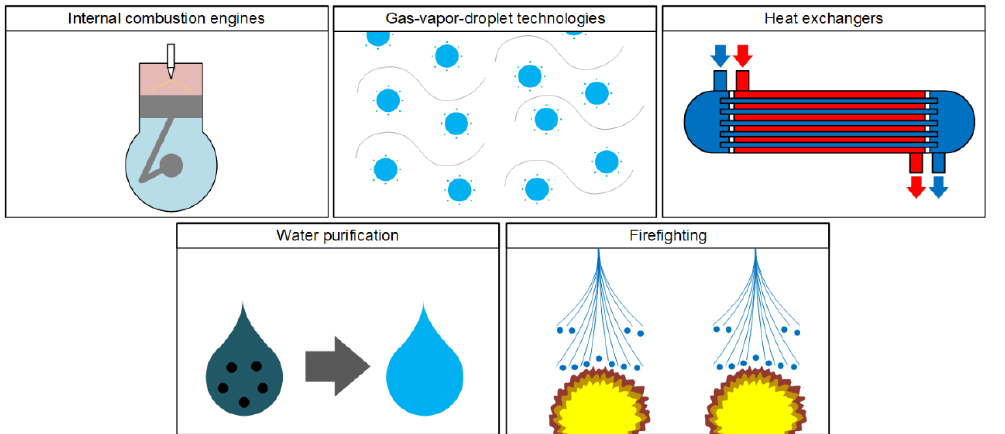
Figure 1. High-potential fields of use for the micro-explosive atomization of liquid droplets.